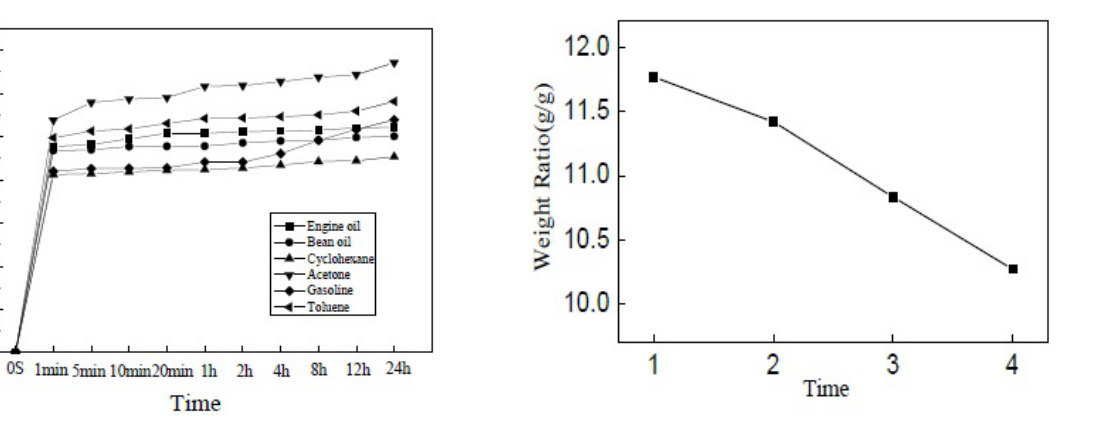
Figure 10: The oil adsorption rates of the freshly prepared and the recycled HPRs for